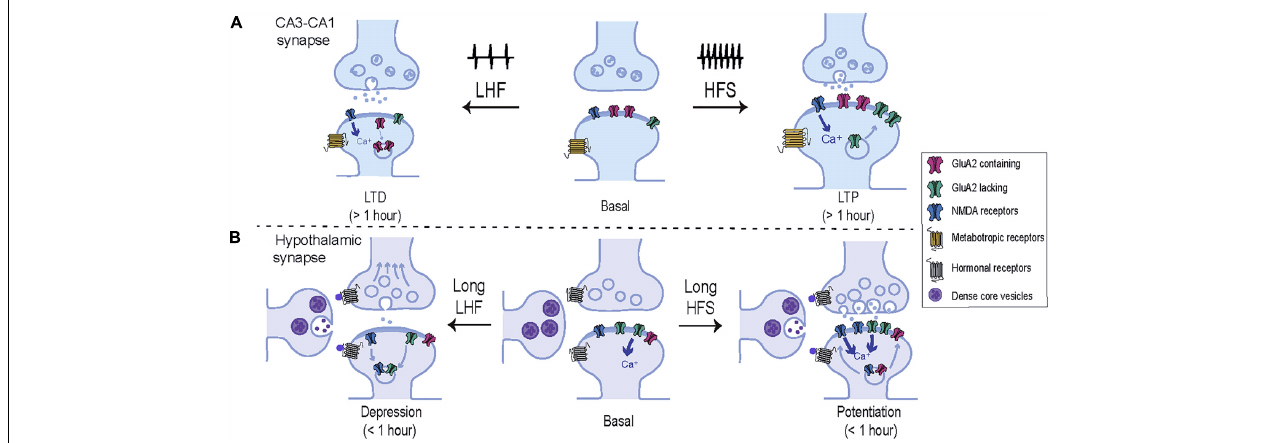
FIGURE 2 | Comparative representation of the molecular mechanisms underlying plasticity in hippocampal and hypothalamic synapses. (A) Schematic representation of the model CA3-CA1 synapse. High frequency stimulation (HFS) induces calcium entry trough NMDARs activating intracellular signaling cascades that drive new AMPARs including GluA2-lacking receptors, into the synaptic membrane. These changes result in a long-lasting potentiation of the synaptic strength and an increase in spine volume. In contrast, low frequency stimulation (LFS) induces a moderate entry of intracellular calcium which drives AMPARs out from the plasma membrane, weakening synaptic strength and decreasing the spine volume. (B) Schematic representation of a hypothalamic synapse. In addition to glutamatergic inputs, hypothalamic synapses are heavily influenced by hormonal secretion from neighboring peptidergic neurons. In contrast to classical plasticity protocols in the hippocampus, hypothalamic synapses commonly exhibit short-term adaptions in response to prolong and low frequency patterns of activity. Short-term potentiation of synaptic strength can be achieved by activation of postsynaptic NMDAR and an increase of synaptic AMPARs, enriched in GluA2-lacking subunits. In addition, NMDARs can be rapidly recruited at synaptic localizations in parallel to presynaptic changes. On the other hand, hypothalamic synapses undergo short-term synaptic depression in response to low frequency stimulation by several mechanisms which may involve the activation of peptidergic or NMDA receptors, that drive the removal of synaptic GluA2-lacking AMPARs, NMDARs, and reduce glutamate release